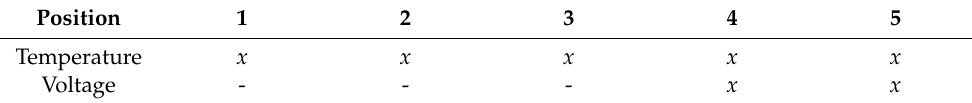
Table 2. Temperature and voltage measurements with CFRC plates. Position 1